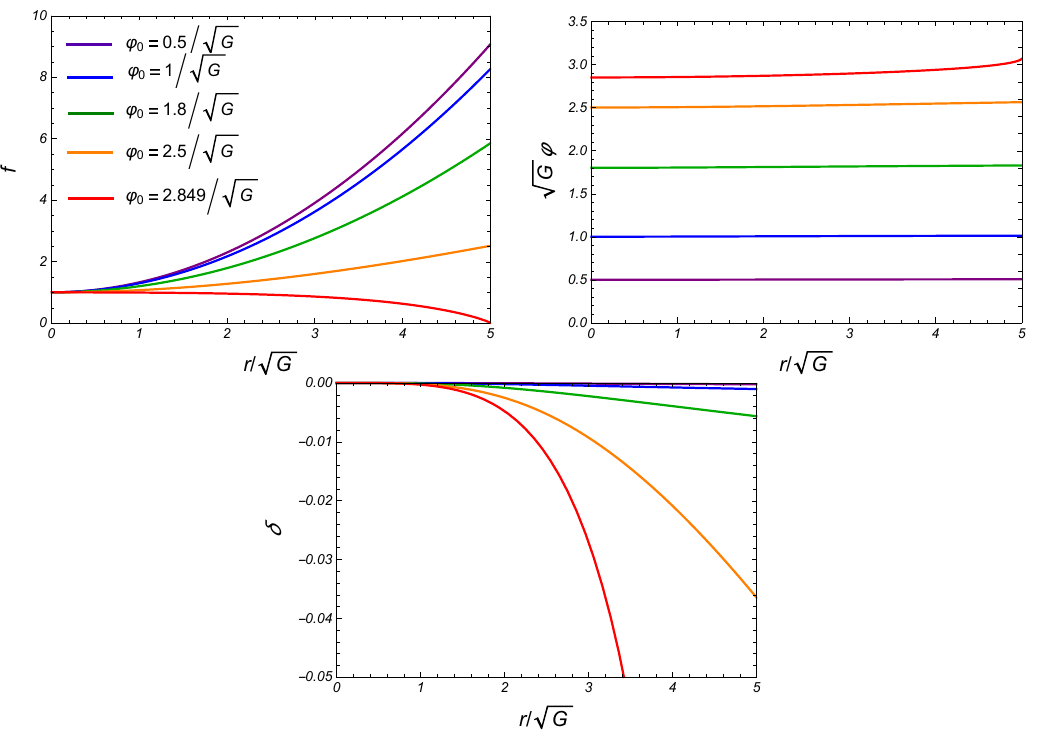
√ √ √ √ G, 1 / G, 1 . 8 / G, 2 . 5 / G , and